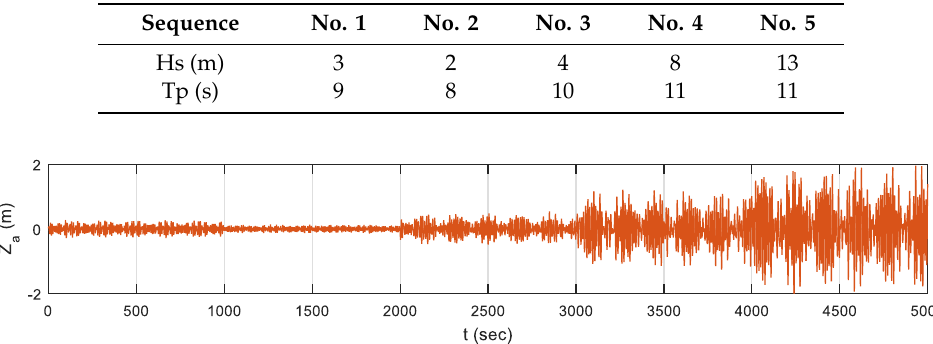
Table 3. Simulated sea state sequence along the route.